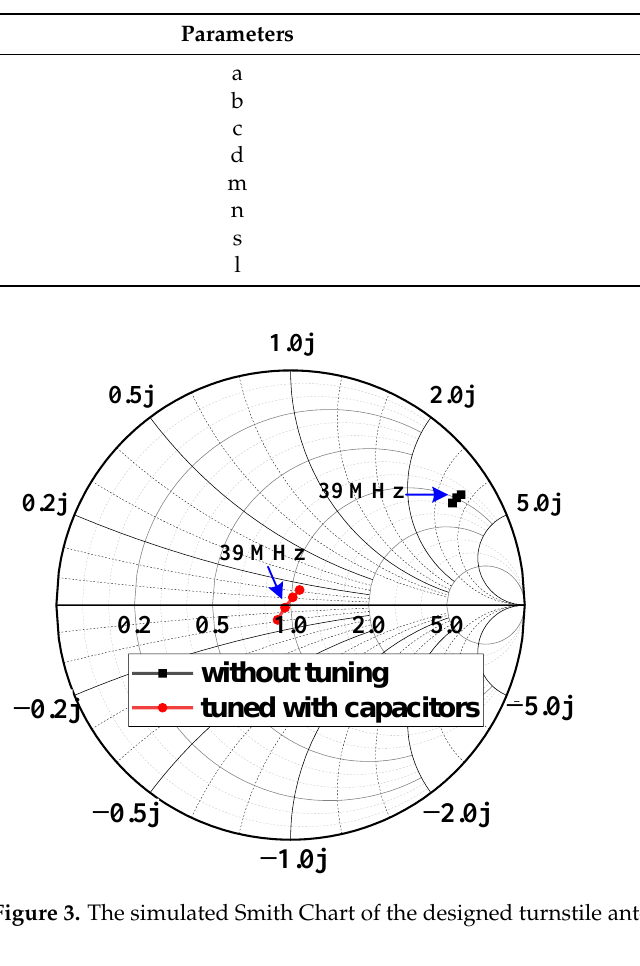
Table 1. Optimized dimensions of the antenna; all dimensions in mm.